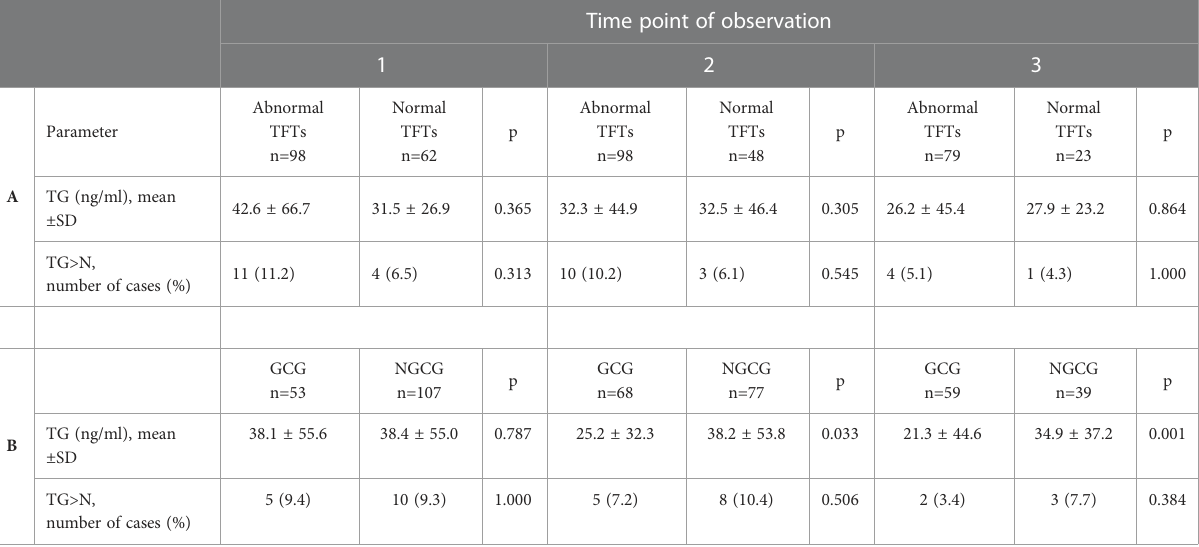
TABLE 3 TG concentration and cases with TG exceeding the upper limit of the norm: A. in individuals with abnormal versus normal results of thyroid function tests; B. in individuals treated versus not treated with